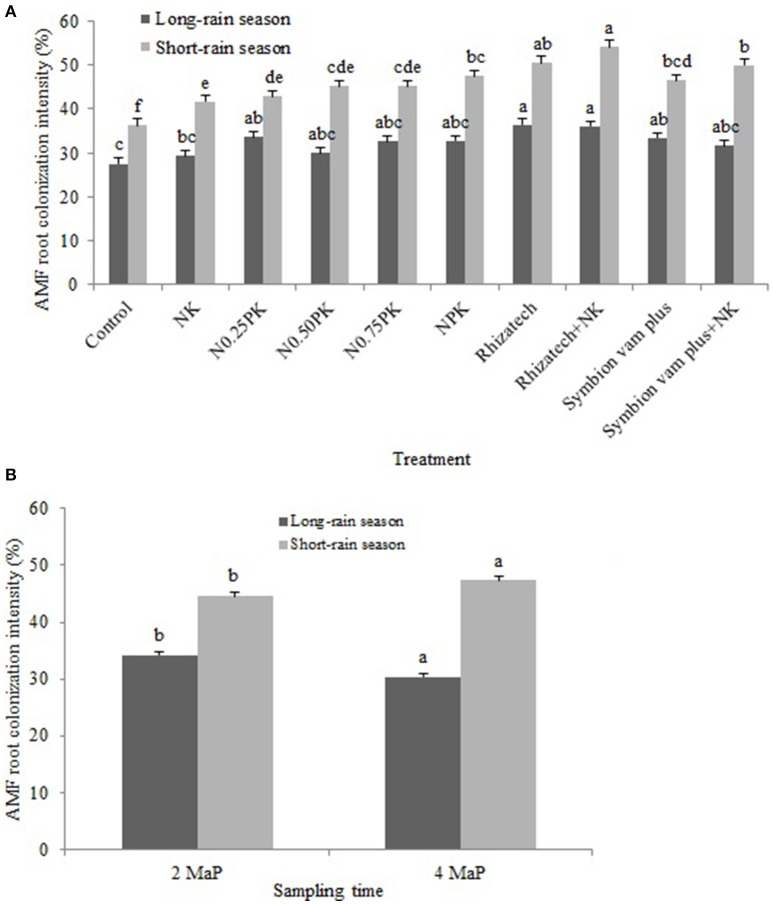
(A) Arbuscular mycorrhizal fungi root colonization intensity as influenced by the interaction of treatment and season; (B) Arbuscular mycorrhizal fungi root colonization intensity as influenced by the interaction of sampling time and season.